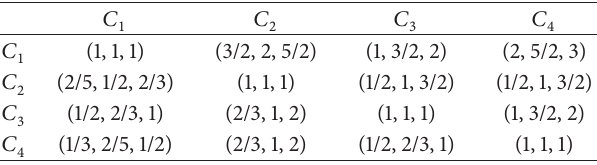
Table 3: Pairwise comparison matrix of main factors.